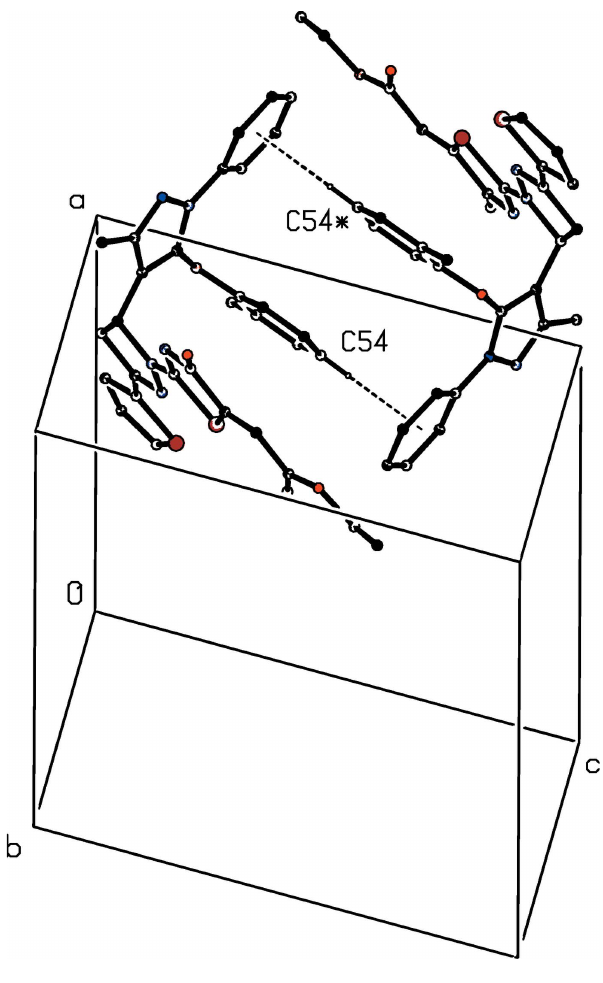
Figure 8 Part of the crystal structure of compound (II) showing the formation of a cyclic centrosymmetric dimer containing C—H (cid:2)(cid:2)(cid:2) (cid:2) (arene) hydrogen bonds. For the sake of clarity, the minor disorder components, and the H atoms not involved in the motif shown have been omitted. The atom marked with an asterisk (*) is at the symmetry position (2 (cid:5) x , (cid:5) y , 1 (cid:5) z